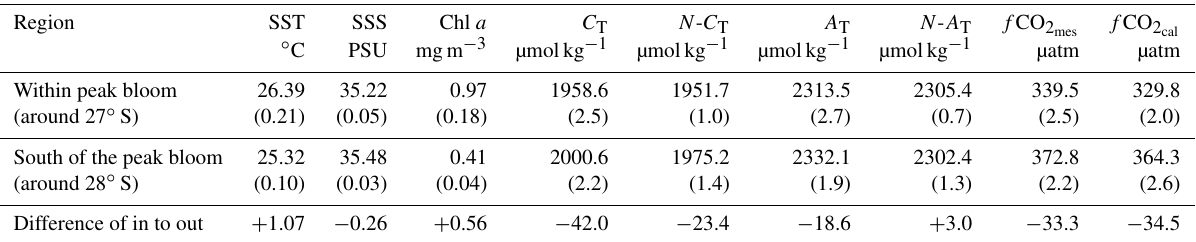
Figure 3. (a) Sea surface f CO 2 (µatm) measured in January 2020 (black circles) and Chl a (mgm − 3 ) from MODIS (4km × 4km) along the cruise track (grey triangles). (b) Sea-surface-salinity-normalized C T ( N - C T , open circles) and salinity-normalized A T ( N - A T , black squares) measured in January 2020 (both in µmolkg − 1 ). Low f CO 2 and N - C T concentrations recorded around 27 ◦ S were linked to high Chl a (up to 1.2mgm − 3 ) in the SEMB. In panel (a) the dashed line represents the average atmospheric f CO 2 for January 2020. Table 1. Mean properties and their difference observed in January 2020 within and out of the SEMB peak bloom. For f CO 2 , results based on measurements ( f CO 2 ) or calculated using A T – C T pairs ( f CO 2 ) are both listed. Standard deviations are indicated in brackets. PSU: mes cal practical salinity